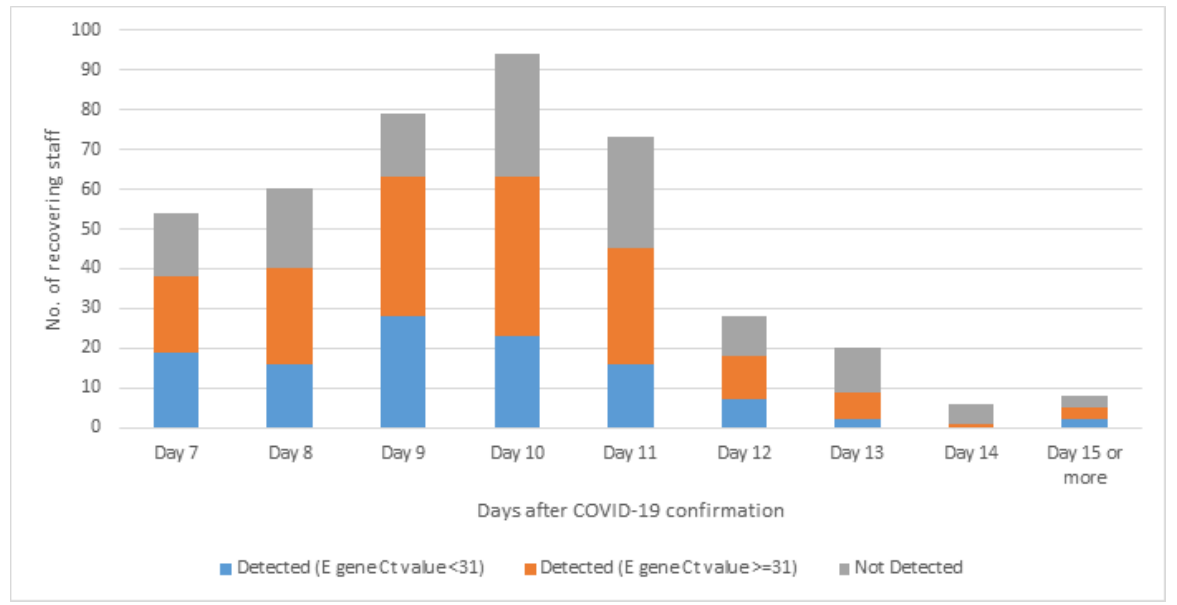
Figure 3. First RT-PCR result after 2 consecutive negative rapid antigen tests in recovering staff who were previously fully vaccinated (N = 422). Table 7. Association between vaccine regime, gender, age, and time taken to return to work after COVID-19 # . Mean No. of Days Taken to p -Value * N Fulfil RT-PCR Criteria for Return-to-Work # Vaccine